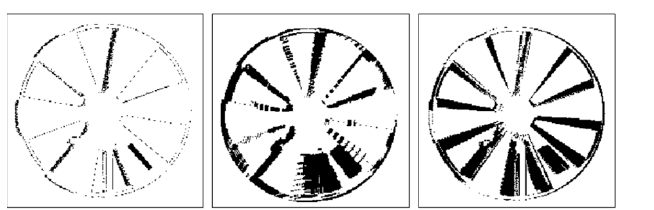
Figure 13. Combined radial ‐ linear motion from left to right without motion ( left ), with synthetic motion blur ( middle ), and with real linear motion blur ( right ).